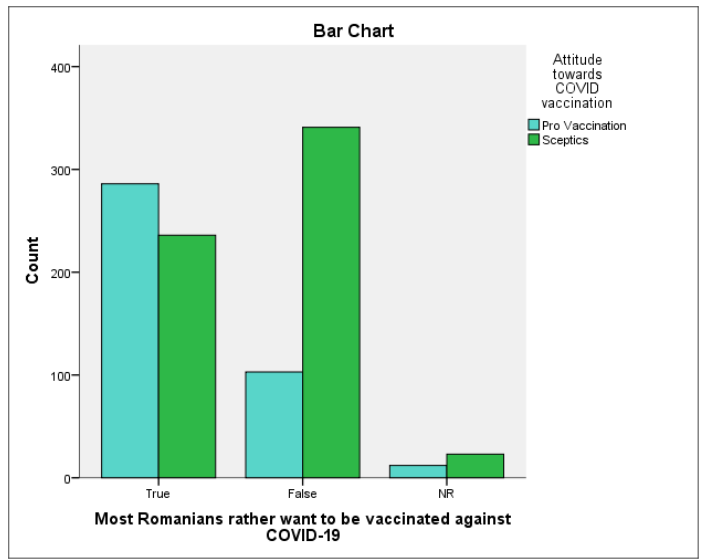
Figure 2. Individual’s attitude towards vaccination vs. the perception of the attitude of fellow countrymen towards vaccination.